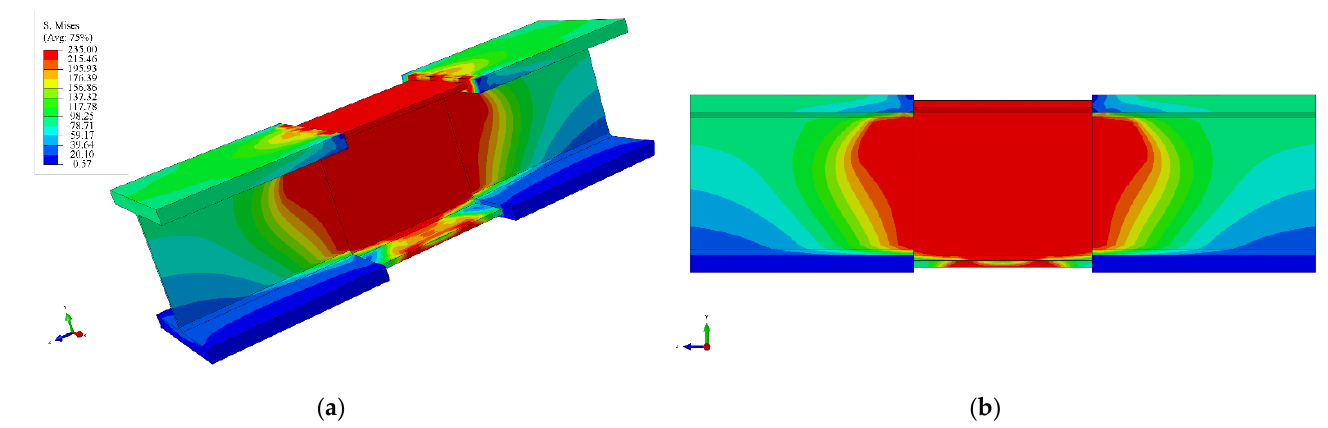
Figure 18. von Mises’ stress map (MPa) for LRPD HEA300 (DP2) at the ultimate loading condition: ( a ) perspective view; ( b ) lateral view.